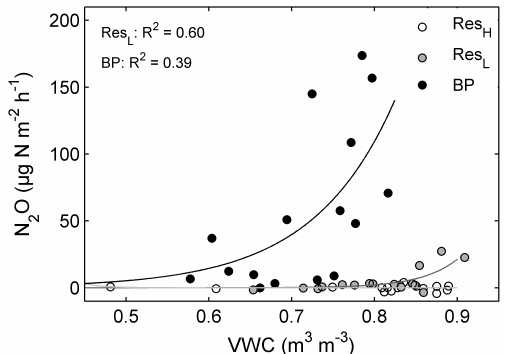
Figure 4. Response of ecosystem respiration ( R e ; mgCm − 2 h − 1 ) to changes in soil temperature ( T s ) measured at 10cm soil depth in restoration treatments with high (Res H ) and low (Res L ) water table level and bare peat (BP).